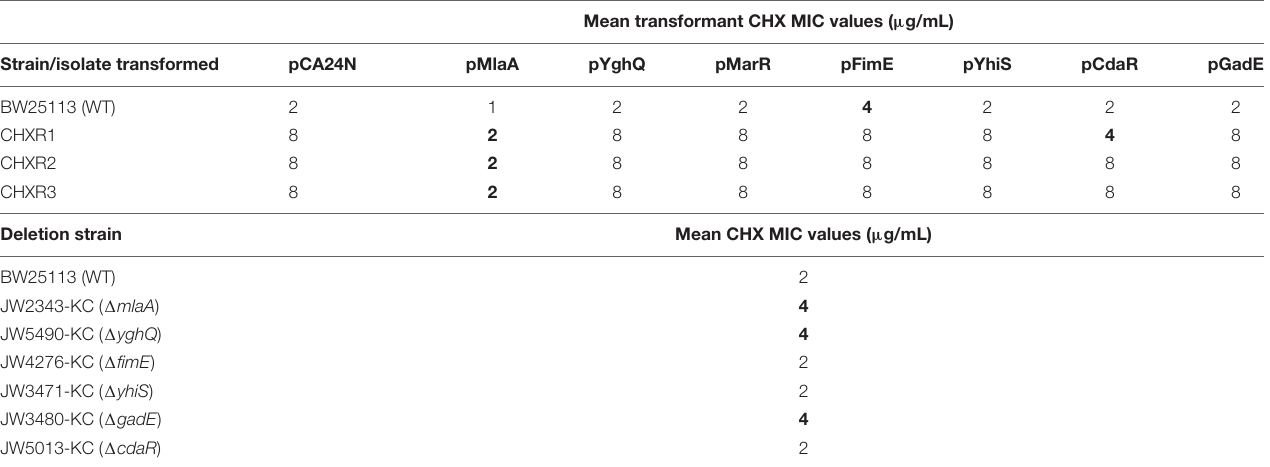
TABLE 5 | A summary of CHX MIC values from AST of plasmid transformed WT, CHXR isolates, and E. coli K-12 single gene